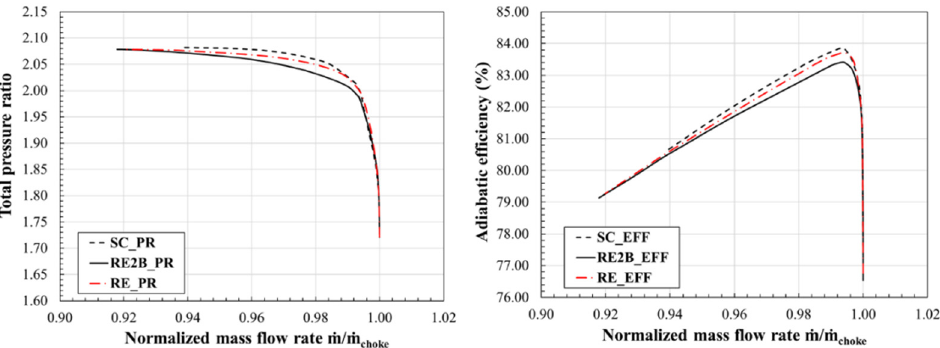
Figure 5. Performance curves for three configurations.